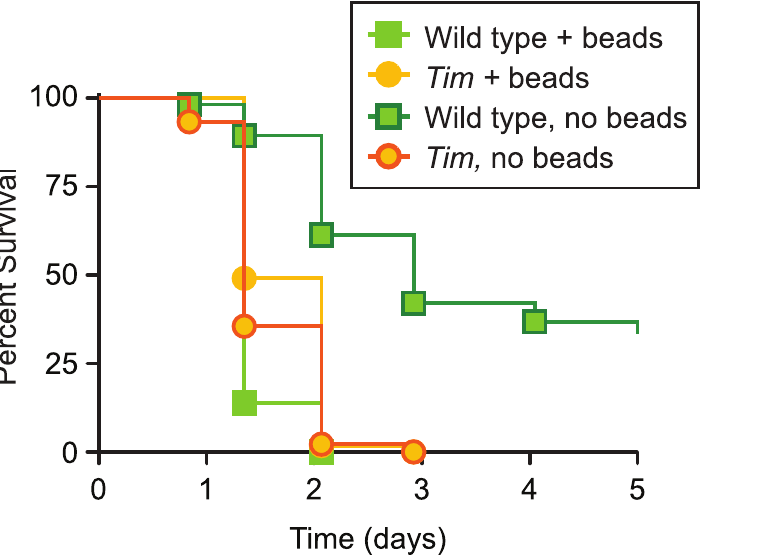
Figure 6. Bead inhibition of phagocytosis in wild type flies eliminates the difference in survival kinetics with Tim mutants after S. pneumoniae infection. Shown here are Kaplan-Meier survival curves comparing wild-type flies and Tim mutants infected with S. pneumoniae with and without pre-injection of beads to inhibit phagocytosis. Infected wild-type flies pre-injected with beads were more sensitive than wild-type flies without pre-injection (p , 0.0001) and had similar survival kinetics as Tim mutants (p=0.0502). Infected Tim mutants had identical survival kinetics with or without bead pre-injection (p=0.1327). In this experiment infected, bead-injected wild-type flies were more sensitive than infected, bead- injected Tim mutants (p , 0.0001); however, this result varied from experiment to